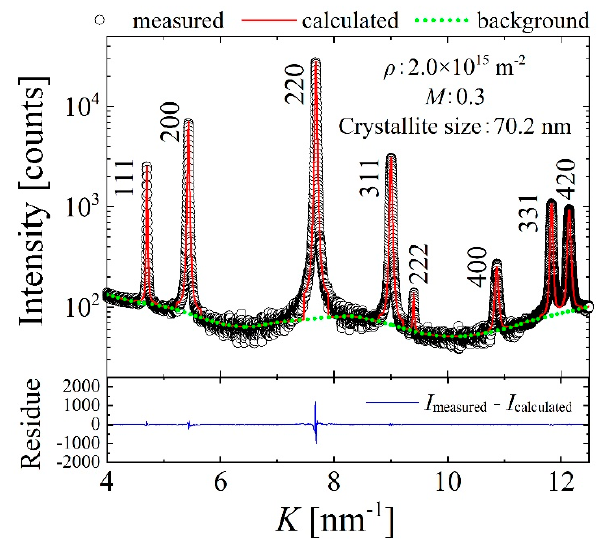
Figure 2. Convolutional multiple whole profile (CMWP) fitting for XRD patterns of the Cu-30% Zn specimen at a true strain of 0.34.